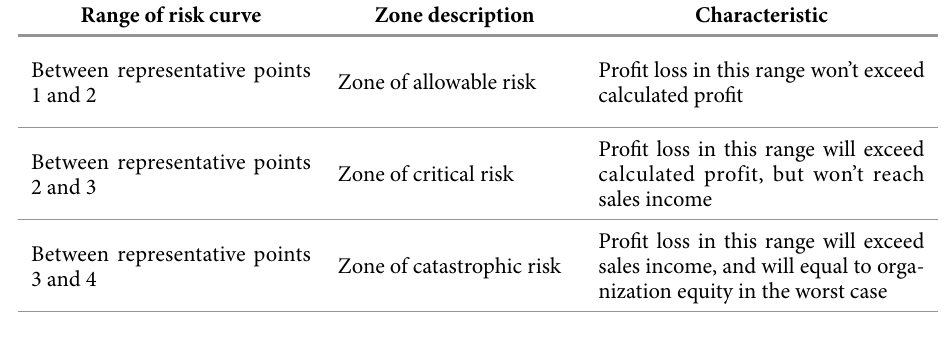
Table 2. Risk zones Range of risk curve Zone description